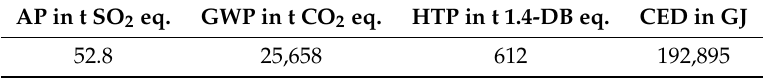
Table 5. Life Cycle Assessment results for Perleberg with 4181 m and 241 m 3